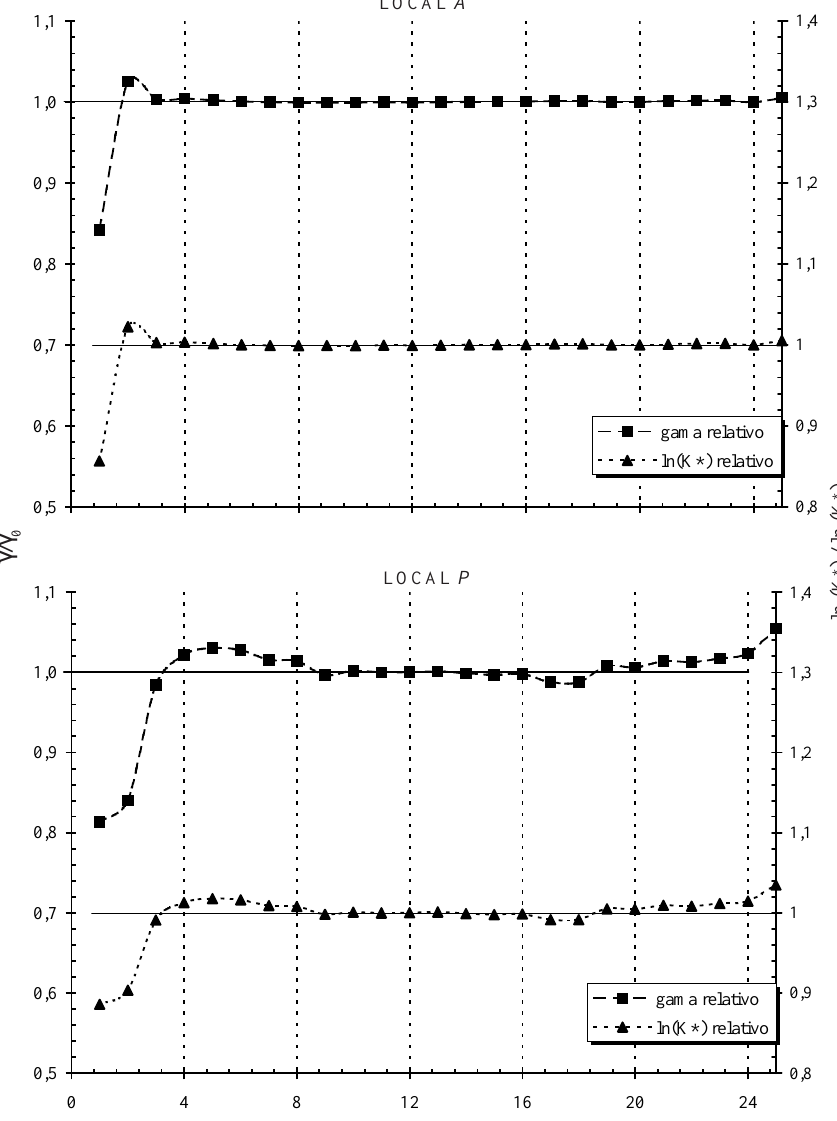
Figura 3. Valores de ggggg e ln(K * ), obtidos eliminando-se uma por uma cada uma das 25 leituras realizadas nos locais A e P , relativos, respectivamente, aos valores de ggggg de